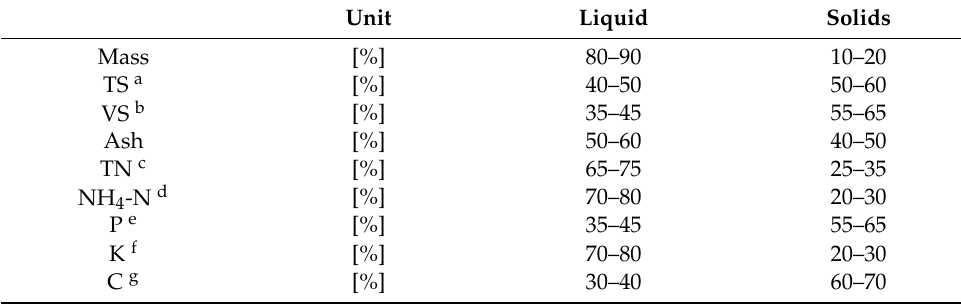
Table 3. Distribution of mass and nutrients after solid–liquid separation